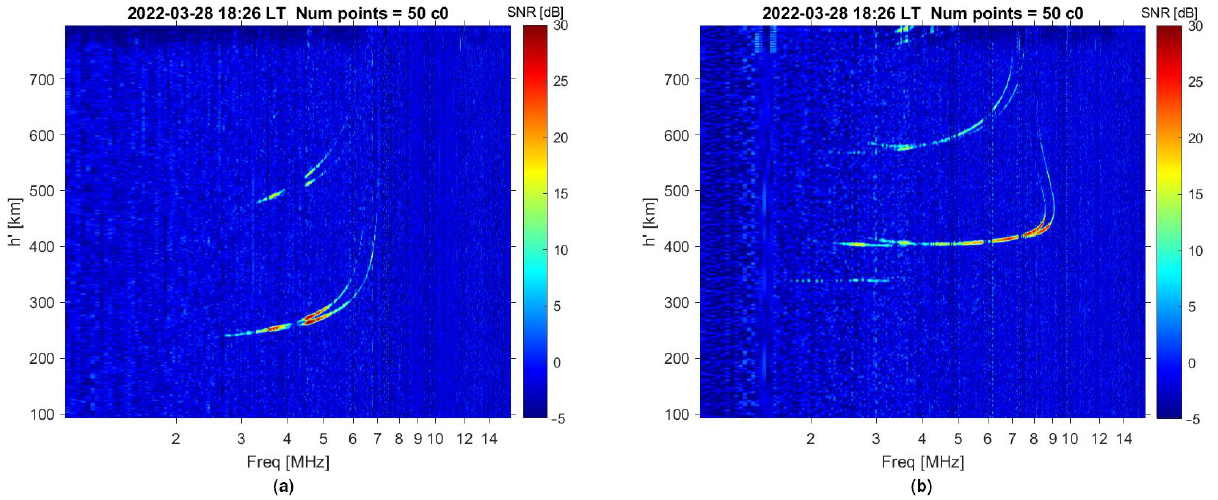
Figure 5. ( a ) Ionogram at UAS and ( b ) ionogram onboard the RV “Noosfera” (coordinates: 60.398532° S, 58.403656° W; distance: ~615 km) obtained on 28 March 2022 at 18:26 LT (LT = UT — 4h). Additional information can be found in Supplementary Materials.